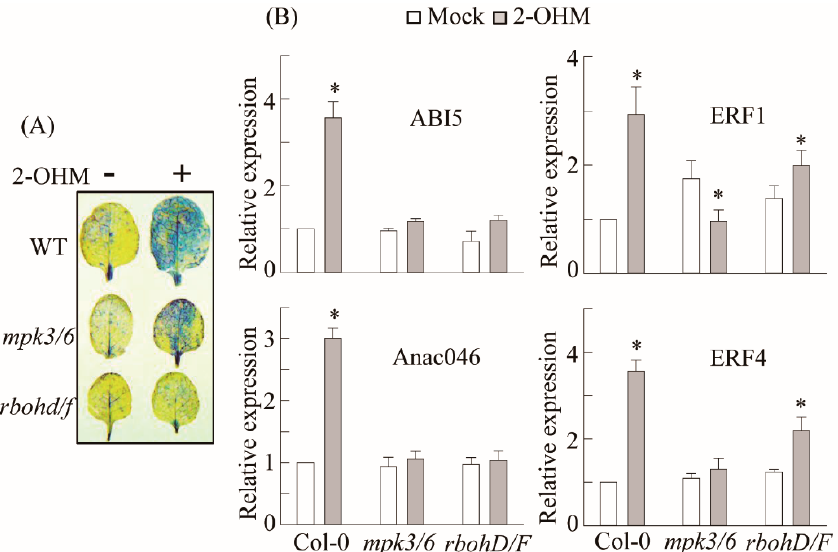
Figure 6. Involvement of MPK3/6 and RHOHD/F in 2-OHM-mediated superoxide and senescence- related gene induction. ( A ) Determination of superoxide levels by NBT staining. ( B ) qRT-PCR analysis results for ethylene and ABA signaling-related genes. Six-week-old WT, mpk3/6 , and rbohD/F leaves were treated with 2-OHM (1 μ M) as described for Figure 3. (*)Asterisks indicate significant differences from the mock control, as determined by Tukey’s post-hoc HSD test, at a level of p < 0.05.